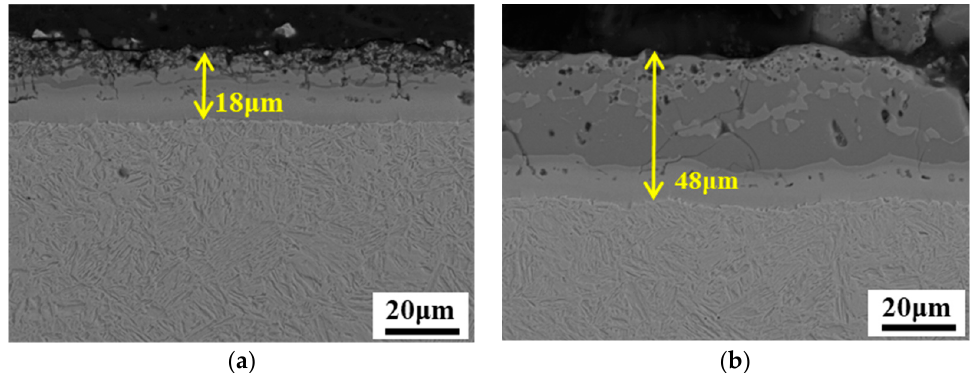
Figure 6. OM micrographs showing the coatings and microstructures After hot stamping: ( a ) Thin 1.4 ; ( b ) Thick 1.4 .